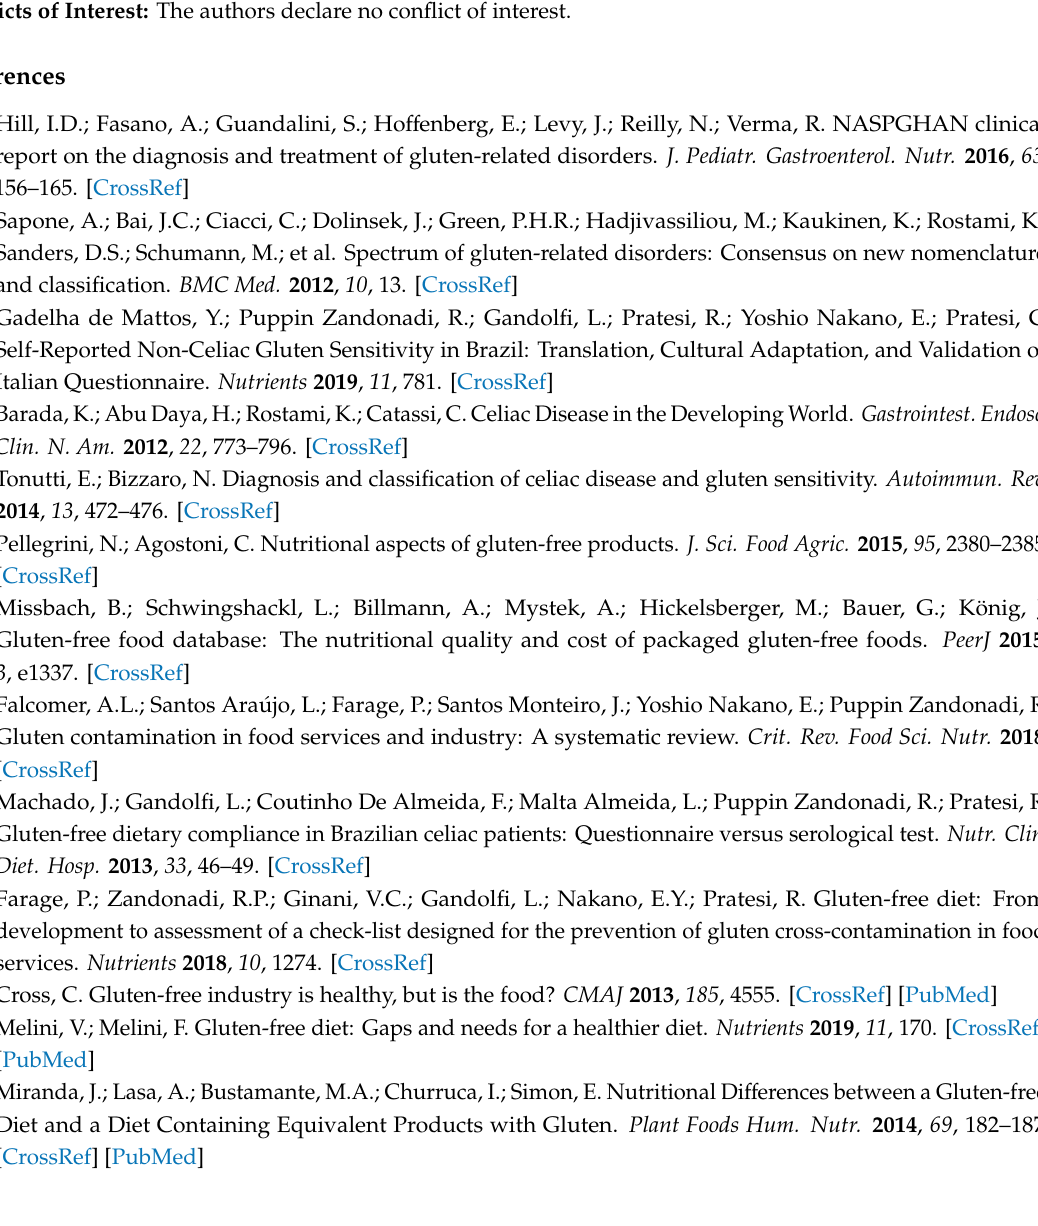
Figure S1: Mean glycemia values for all analyzed GFB, Figure S2: Word Cloud generated from ingredients’ frequency in GFB classified as high Glycemic Index (a) and medium Glycemic Index (b), Table S1: Mean glycemia values in Mmol / L for GFB